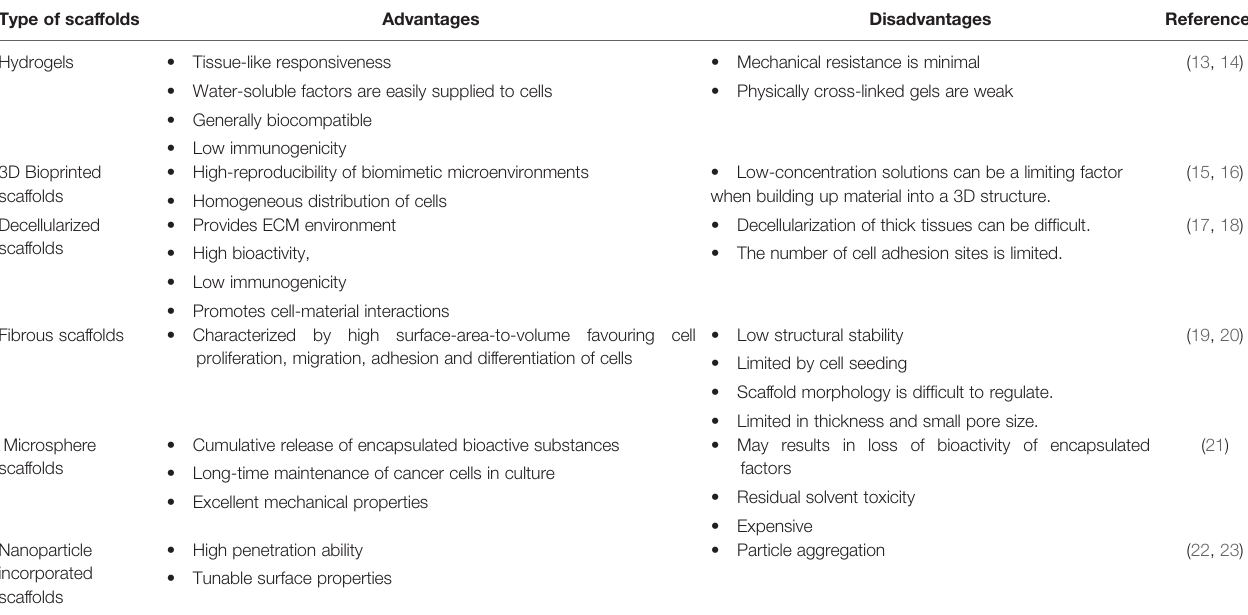
TABLE 1 | Advantages and disadvantages of different scaffolds in tissue